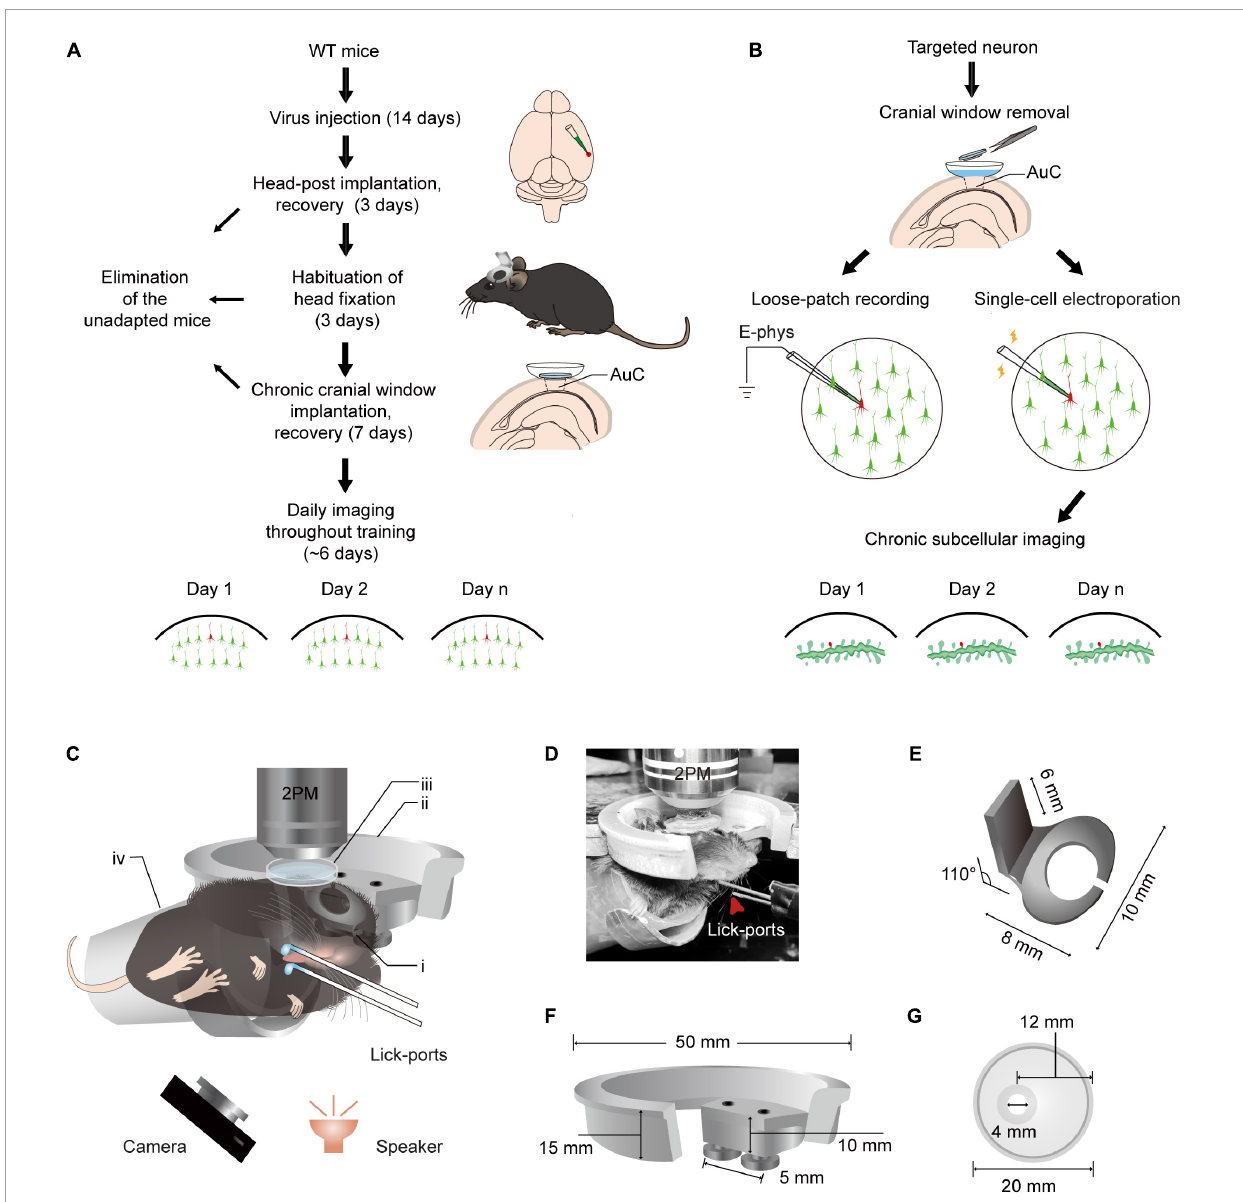
FIGURE1 Training paradigm and updated head fixation apparatus for daily two-photon Ca 2 + imaging in the AuC of behaving mice. (A) Technical flowchart for chronic population two-photon Ca 2 + imaging across sound evoked licking behavior training. (B) Procedure of loose-patch recording and subcellular structure imaging of target neuron after population imaging tracing. (C) A diagram of the setup for simultaneous daily two-photon chronic imaging during training. The camera was used to monitor licking behavior in infrared mode and the speaker was placed 6 cm below the mouse’s left ear. (i) Head-post (panel E ): (ii) recording holder (panel F ); (iii) recording chamber (panel G ); (iv) body tube; 2PM: Two-photon microscope. The detailed size and design of these parts are present below. For assembly of head-post, recording holder, and recording